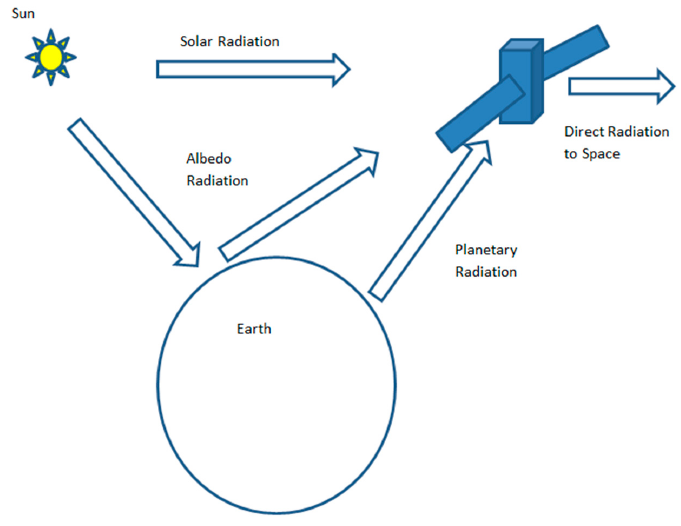
Figure 44. Earths Radiation Loading [22].